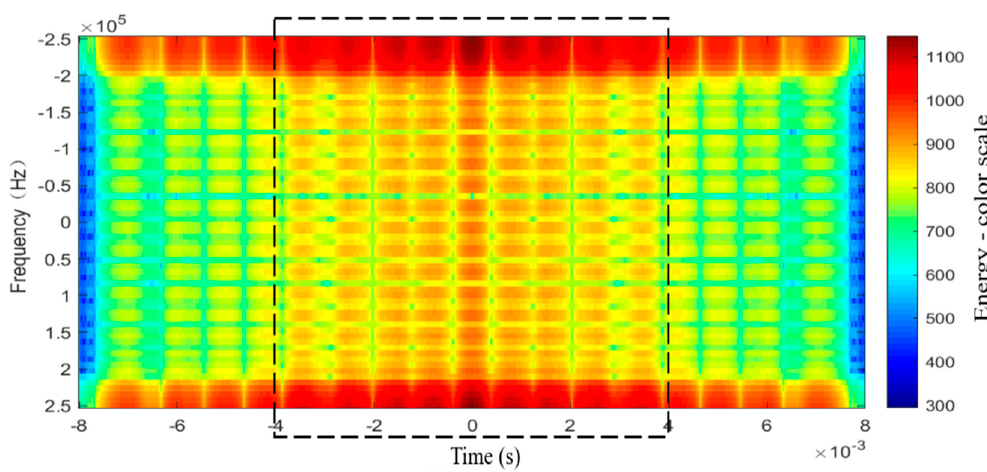
Figure 9. Time–frequency spectrogram (black dotted box indicates the ROI area).